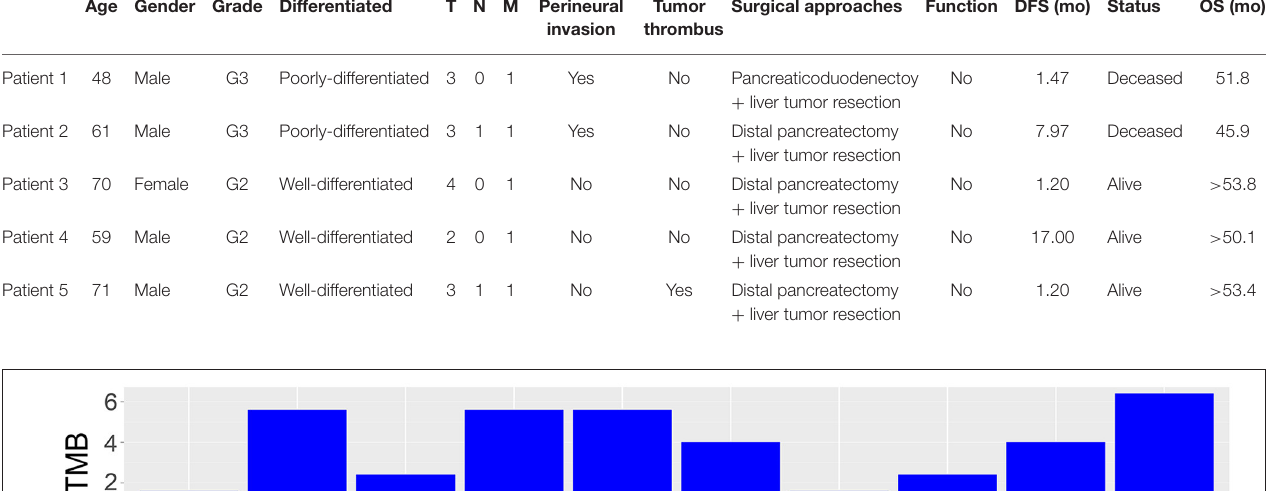
Tumor Surgical approaches Function DFS (mo) Status OS (mo) invasion thrombus